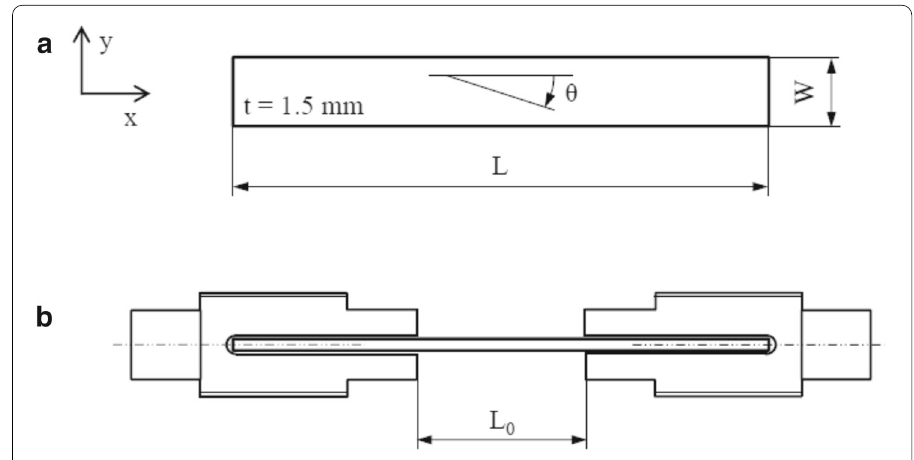
Fig. 1 a Rectangular composite specimen and b assembled specimen